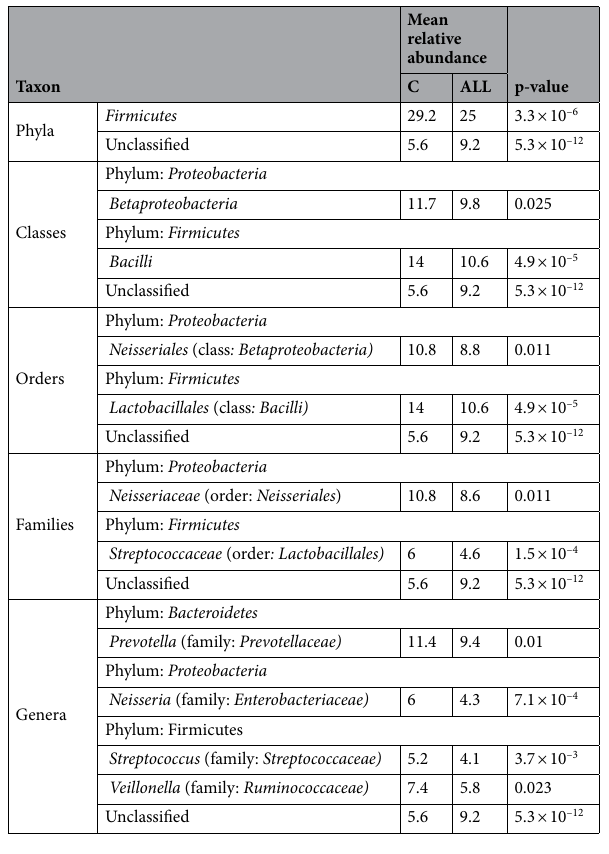
Table 2. Taxa displaying significantly different relative abundances in ALL and C. Wilcoxon–Mann–Whitney and Kruskal–Wallis Rank Sum non-parametric tests were applied, using a significance threshold (p-value) set to 0.05. For each taxon, the immediately higher taxonomic ranking and the phylum are